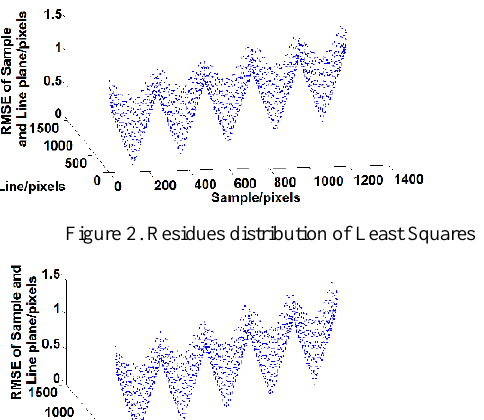
Figure 3. Residues distribution of Orthogonal Distance regression